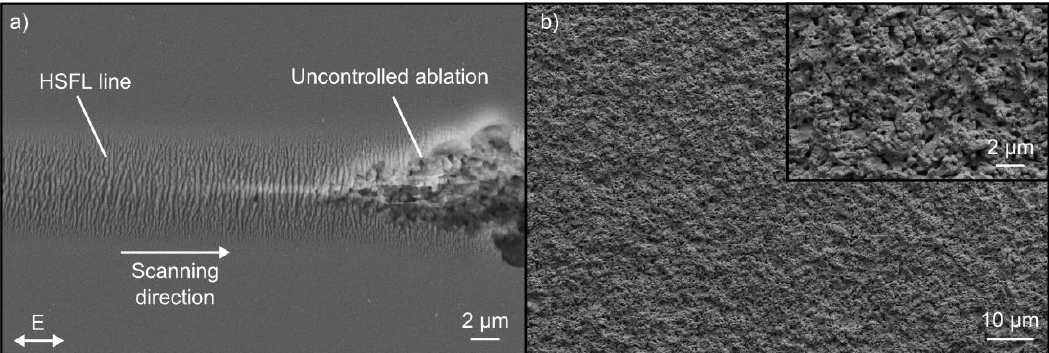
Figure 4. SEM micrographs of an uncoated fused silica surface upon fs-laser irradiation with F = 4.9 J/cm 2 : ( a ) high-spatial frequency LIPSS (HSFL) generated by a single line scan with v = 0.15 m/s; ( b ) Large-area structuring by unidirectional scanning with v = 0.15 m/s and Δ x = 4 µm. The direction of the E -field vector is indicated in ( a ).